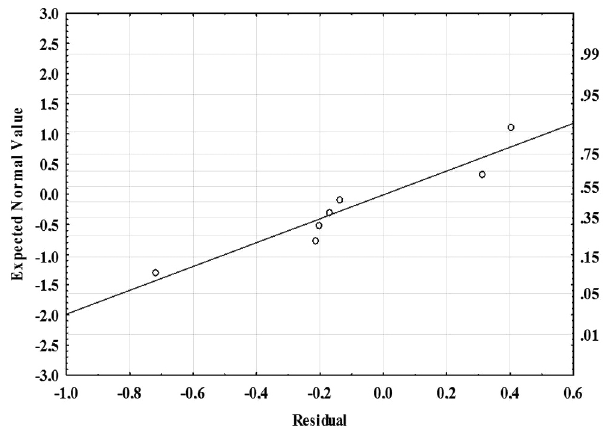
FIGURE 5 - Normal probability plot of errors, based on the residuals obtained from the ID values for amlodipine besylate.